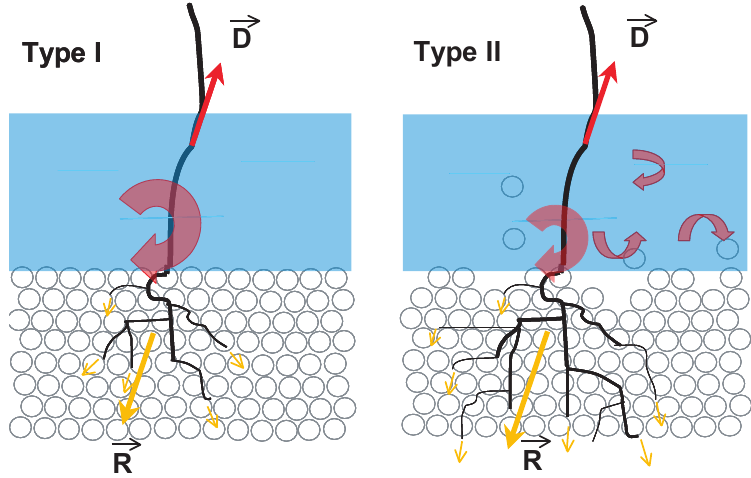
R Fig. 2. Mechanisms of root erosion by flow: Type I is caused by flow-induced drag force. It is assumed to occure rather instantanious and to be relevant to young vegetation. Type II is a combination of local sediment erosion around the plant decreasing the anchorng force until drag force prevails. Type II is more complex, therefore occuring on a larger timescale and relevant to vegetation with more pronounced root systems. 27